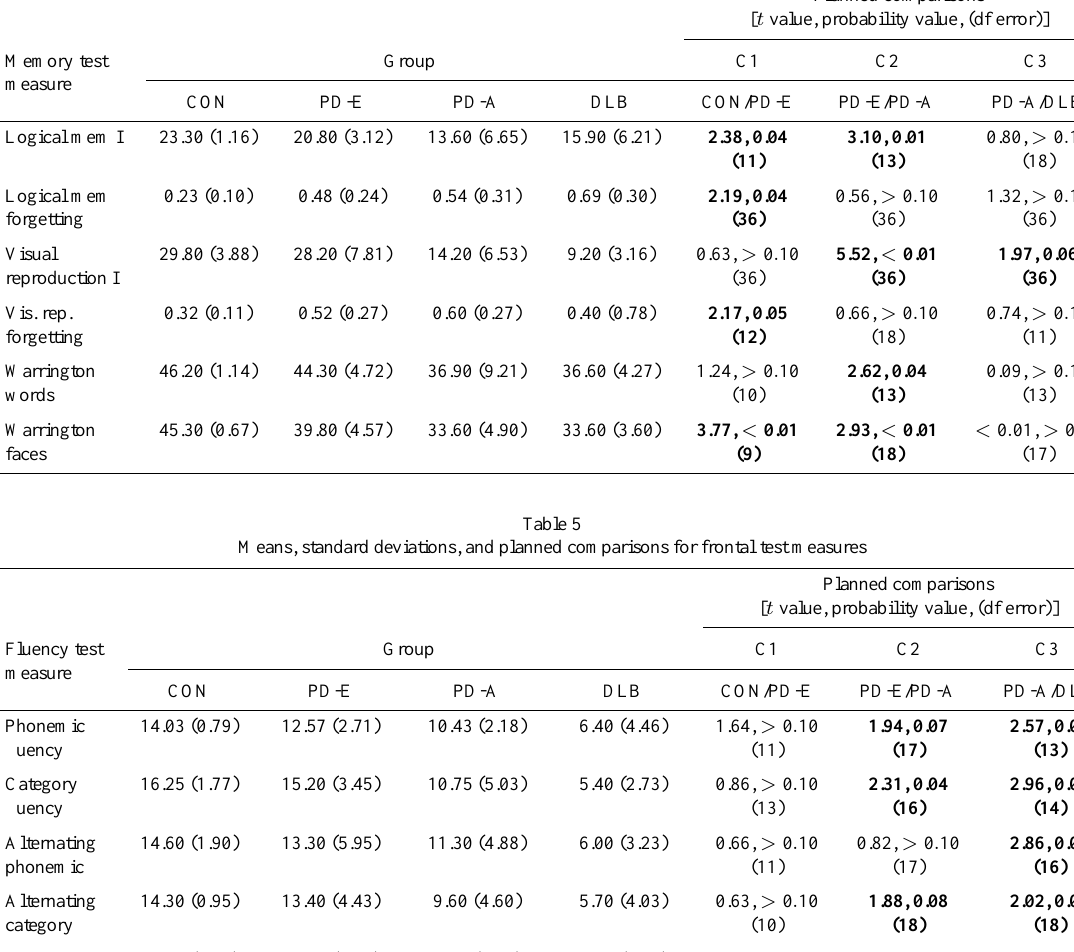
Table 4 Planned comparisons [ t value, probability value, (df error)]